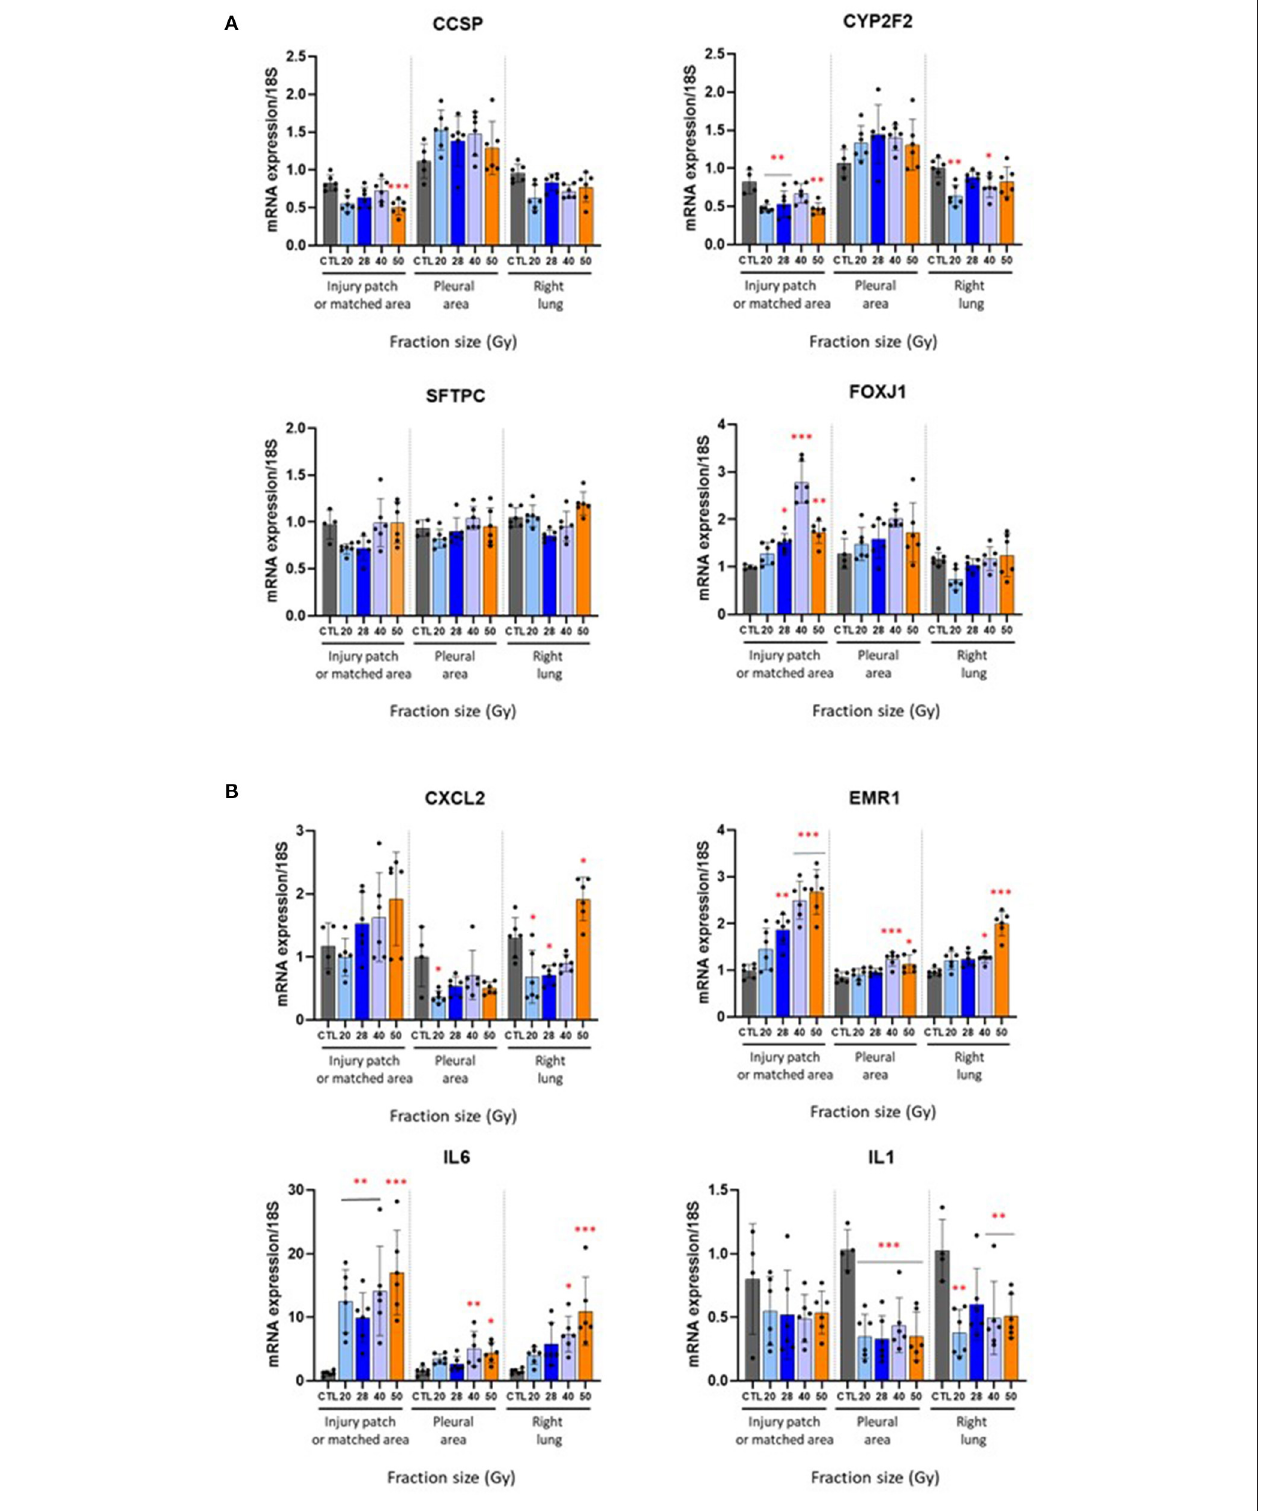
FIGURE 4 | Effect of different fractionation schedules on mRNA expression. Changes in gene expression levels in the injury patch or matched area, pleural area, and right lung 6 months after radiation exposure to 3 × 20, 28, 40 or 50Gy. (A) Club cell (CCSP, CYP2F2), type II pneumocytes (SFTPC), and ciliated cell (FOXJ1) markers. (B) Inflammatory mediators CXCL2, EMR1, IL6, and IL1. * p < 0.05; ** p < 0.01; *** p < 0.001 compared to respective control groups. n = 4–6 per group.